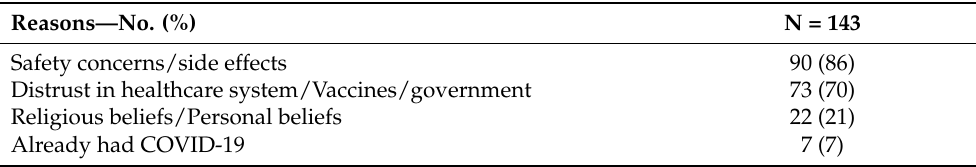
Table 3. Reasons for COVID-19 vaccination hesitancy among respondents who had not received a COVID-19